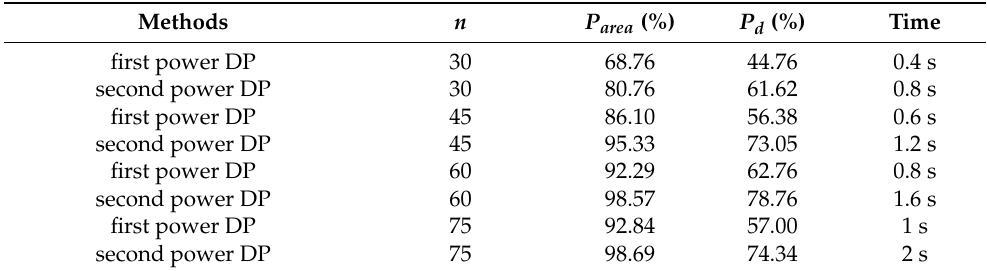
Table 1. Quantitative comparison of